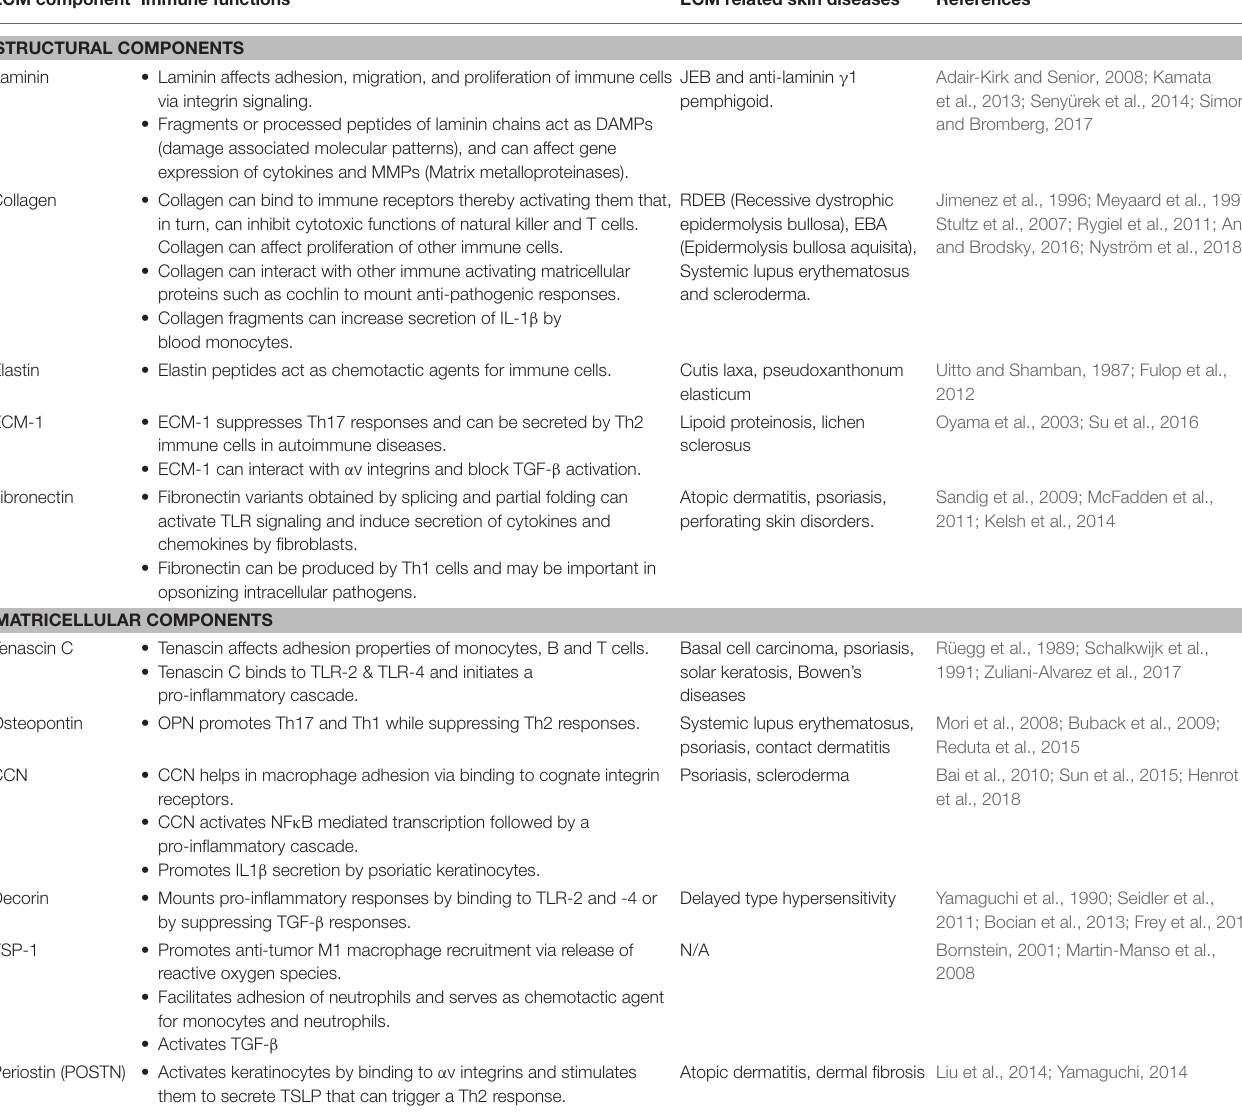
TABLE 1 | Immune functions of ECM. ECM component Immune